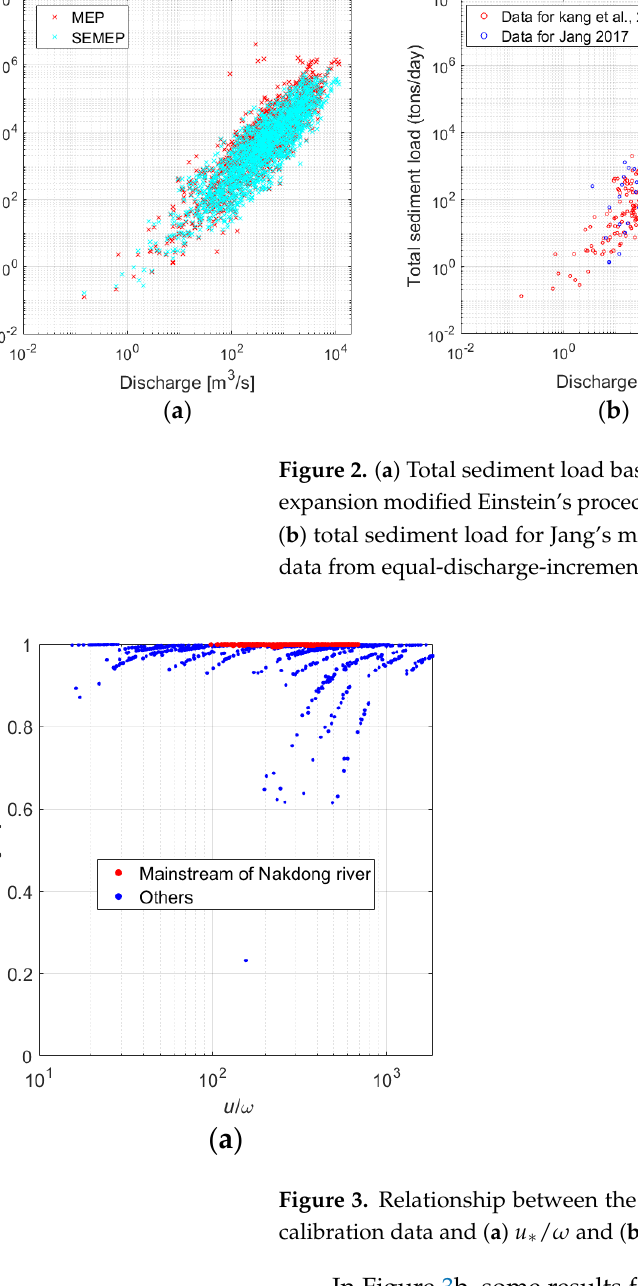
In Figure 3b, some results for gravel and cobble-bed river (tributary) yielded a low